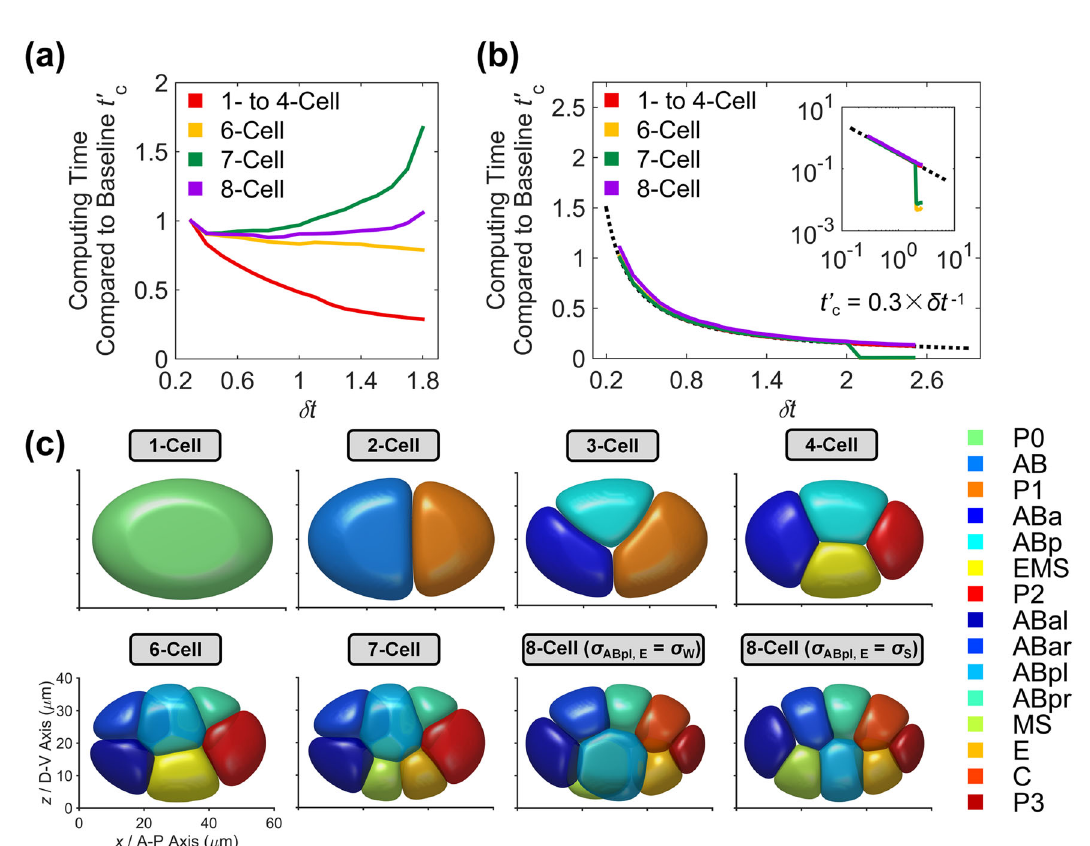
Fig. 2 Framework improvement by the addition of stabilization term. a Computing time compared to the baseline at different stages in the fi rst-order scheme. b Computing time compared to the baseline at different stages in the second-order scheme. In both ( a ) and ( b ), the baseline is set as the computing time when δ t ¼ 0 : 3 and no stabilization term is added. In b , the dashed line is the curve t 0 the inset is the same fi gure presented in a dual logarithmic coordinate system. c Embryonic morphologies from 1- to 8-cell stages in the second-order scheme with δ t ¼ 2 : 0 . The cells ’ identities and corresponding colors are denoted on the right; σ S and σ W denote the relatively strong (i.e., σ S ¼ 0 : 5 ) and weak (i.e., σ W ¼ 0 ) cell – cell attraction inferred at the 4-cell stage respectively (Supplementary Fig. 2a, b and Supplementary Note 1).